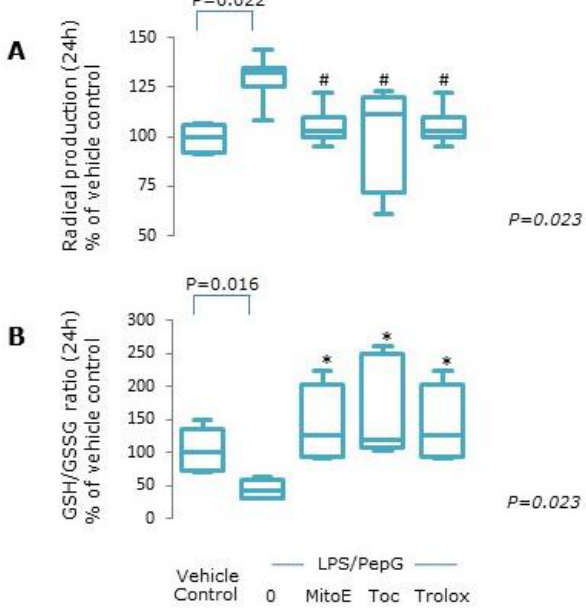
Figure 1. Oxidative stress. Endothelial cells were treated with vehicle control, lipopolysaccharide plus peptidoglycan (LPS / PepG) alone, or LPS / PepG plus 5 µ M MitoVitE (MitoE), tocopherol (Toc) or Trolox for 24 h. ( A ) Total radical production, ( B ) reduced / oxidised glutathione. Box and whisker plots show median, interquartile and full range ( n = 6). p value in italics refers to Kruskal–Wallis across LPS / PepG treated groups. # = significantly lower and * = significantly higher, than LPS / PepG alone ( p < 0.05).